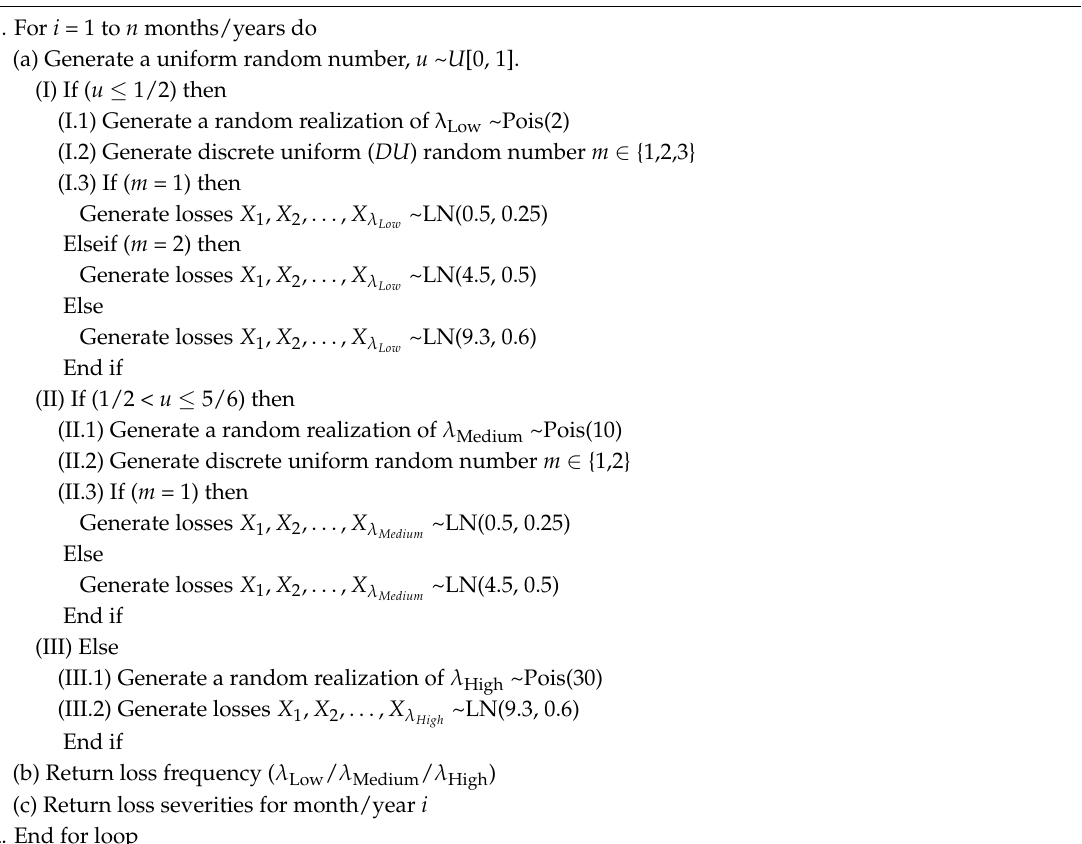
Algorithm A1 Procedure for generating synthetic data corresponding to Scenario (I) 1. For i = 1 to n months/years